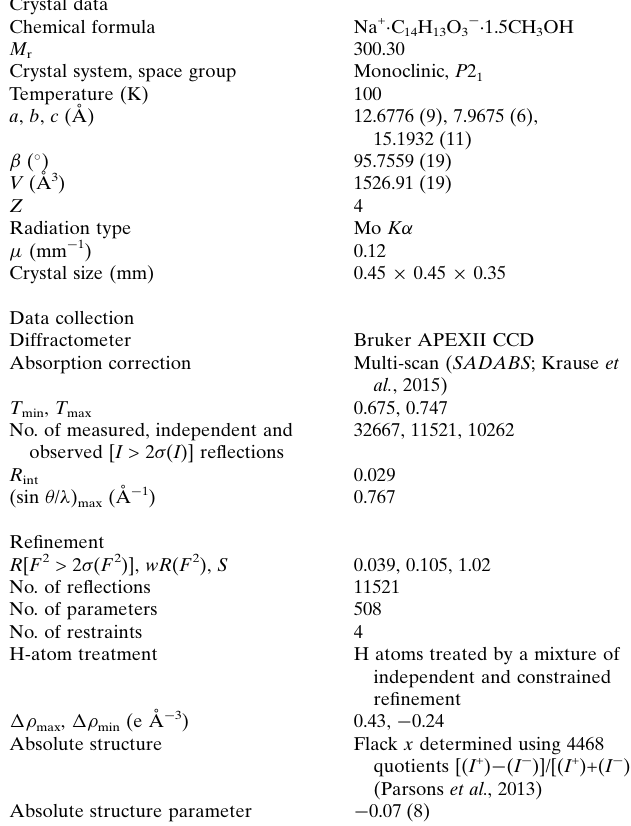
Table 3 Experimental details. Crystal data Chemical formula